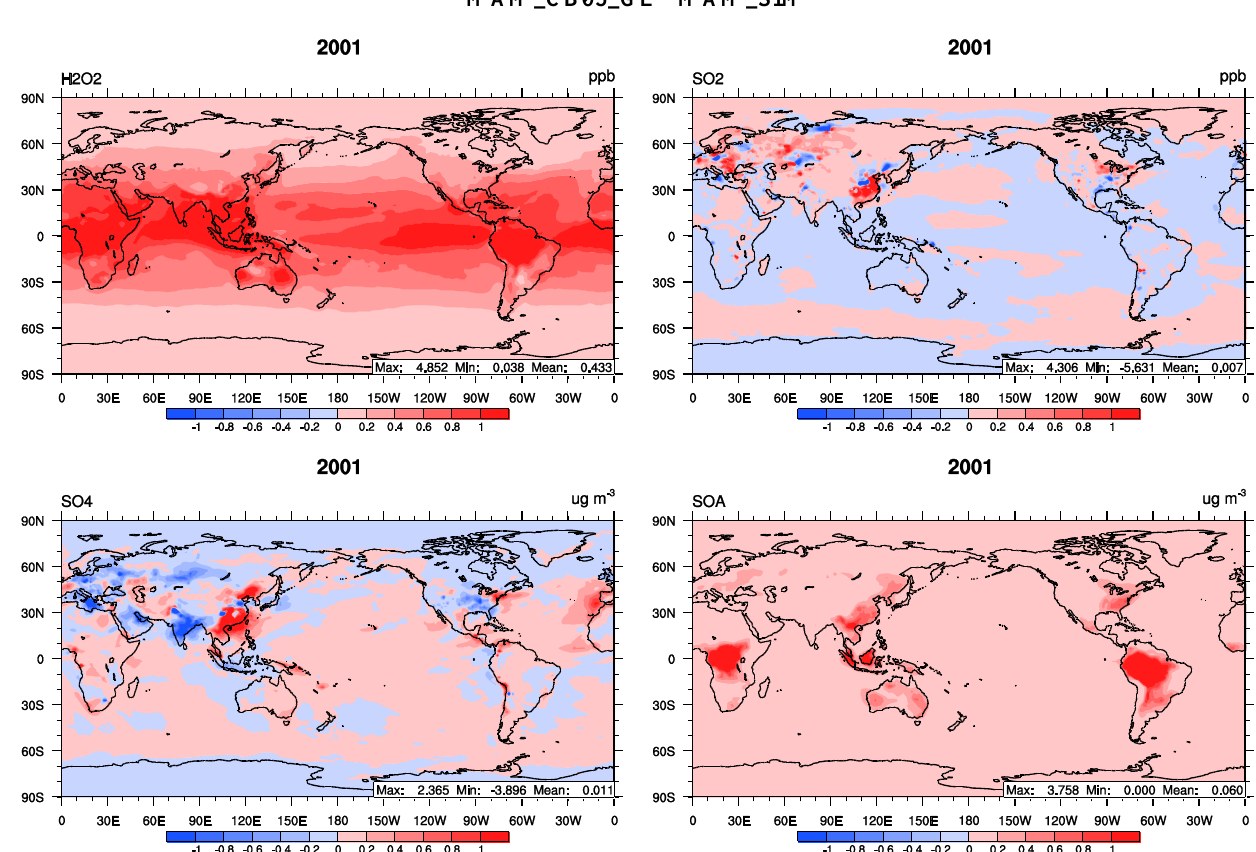
Figure 1a. Absolute differences of H 2 O 2 , SO 2 , SO 42- , and SOA between MAM_CB05_GE and MAM_SIM for 2001.